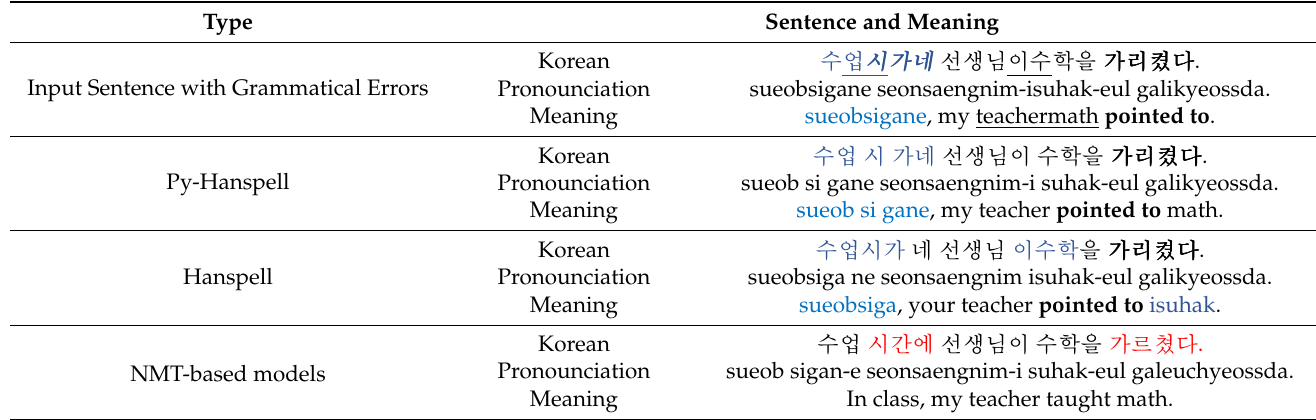
Table 11. Error Correction Results by Four